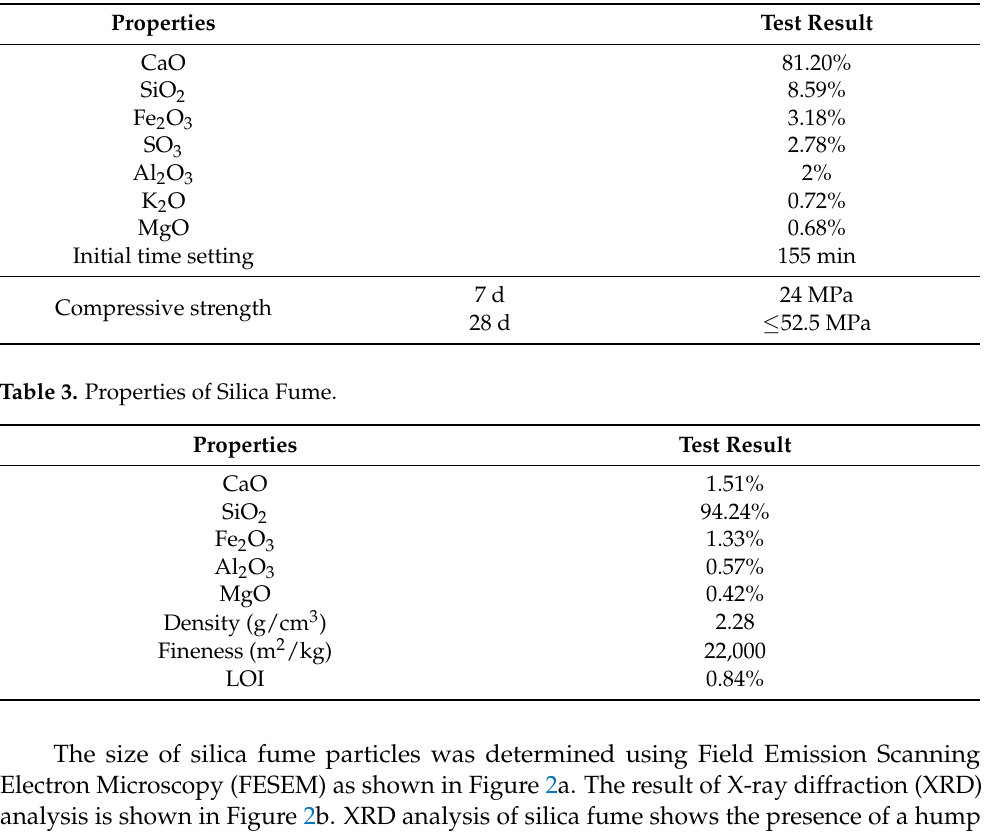
Table 2. Properties of Cement.